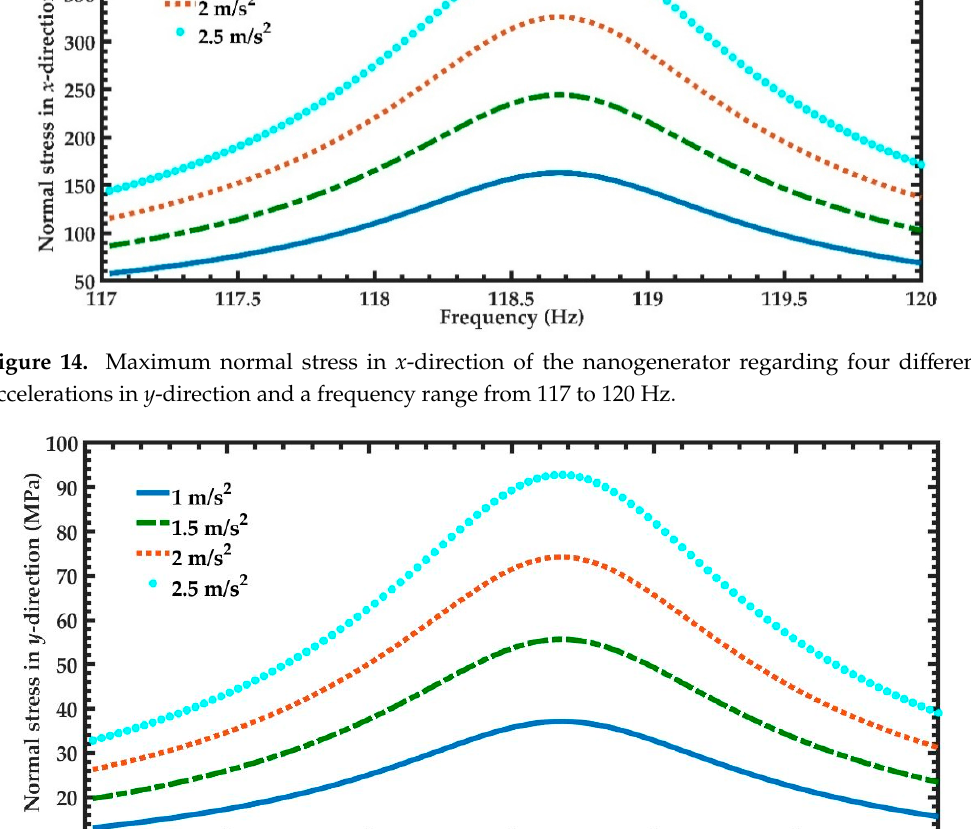
Figure 15. Maximum normal stress in y -direction of the nanogenerator considering four different accelerations in y -direction and a frequency range from 117 to 120 Hz.